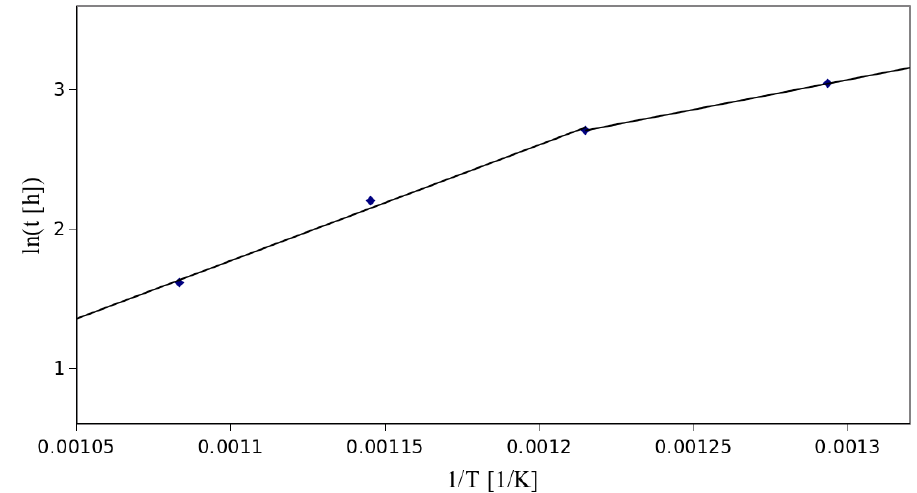
Figure 4. Dependence between the time of breakage and the annealing temperature of copper-coated